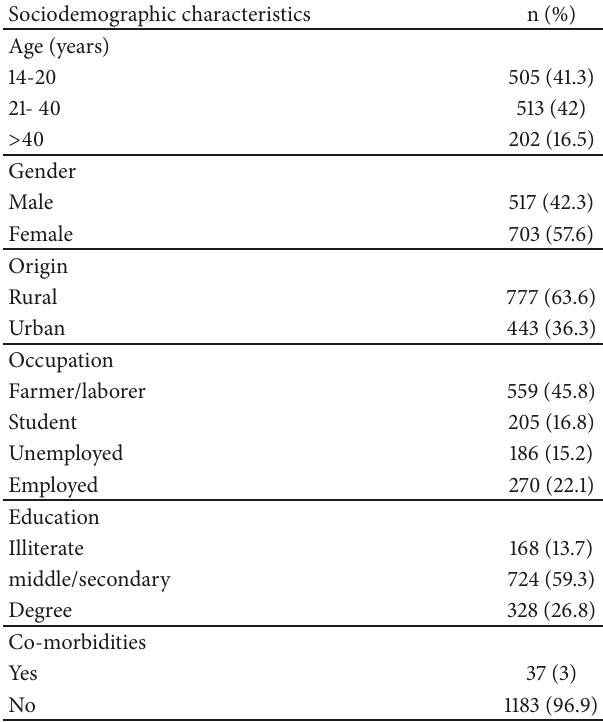
Table 1: Sociodemographic characteristics of extrapulmonary tuberculosis patients